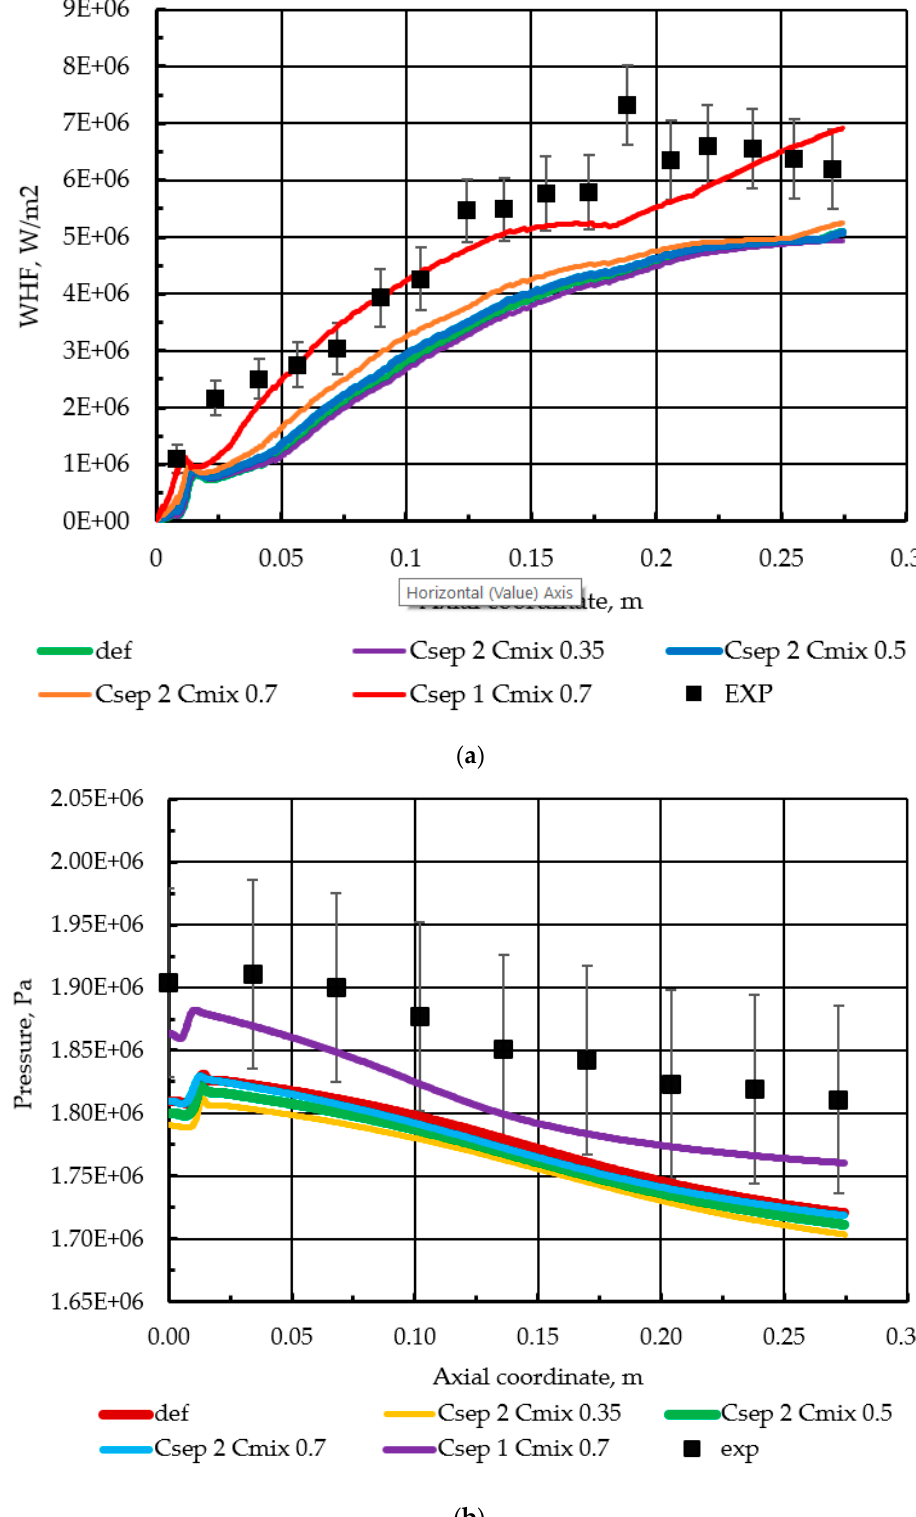
Figure 7. ( a ) Effect of Csep on wall heat flux; ( b ) Effect of Csep on